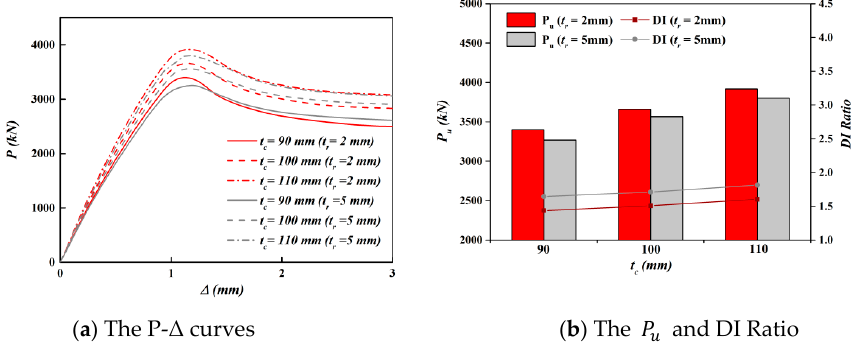
Figure 16. Influence of thickness of concrete on compressive resistance of SDC wall.